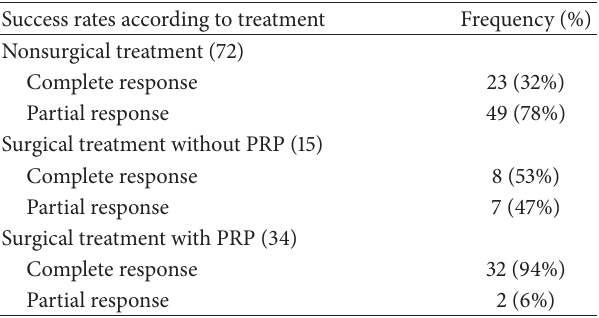
Table 2: Response according to treatment.